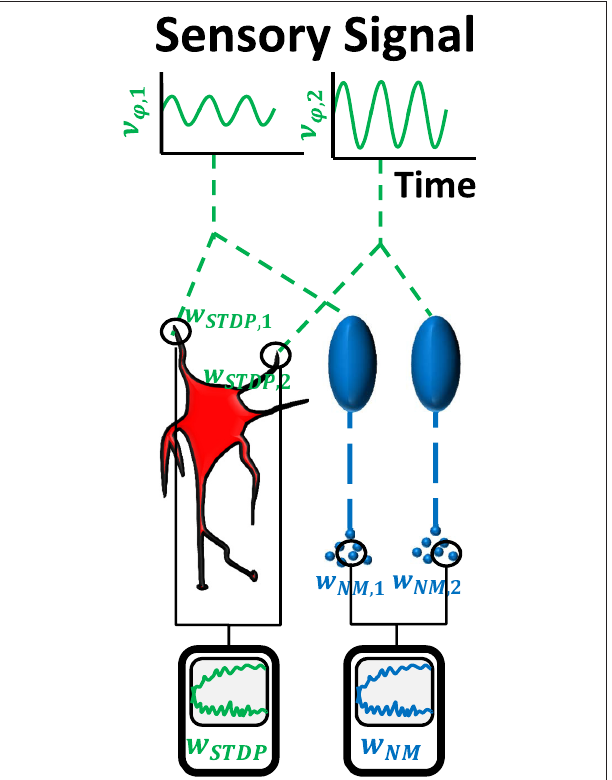
FIGURE 2 | In the first experiment, we verify the possibility to use STDP and serotonin dynamics to obtain the dominant principle component of input signals, by simulating two sensory Poisson neurons. Shown here are their firing rates that evolve according to sinus functions ν ϕ, 1 and ν ϕ, 2 with different amplitude and underlying white noise (noise not illustrated in the picture). The neurons drive a third Poisson neuron (center left). Synaptic weights w STDP , i are subject to STDP and their ratio is expected to converge toward the amplitude ratio of the input sinus functions. Additionally, the input neurons drive two raphe neurons (center right), which release serotonin into separate pools. The serotonin concentration decreases according to Michaelis-Menten dynamics. The ratio of serotonin concentrations is proportional to the ratio of the neuromodulatory weights, w NM , 1 / w NM , 2 , and is also expected to converge toward the amplitude ratio of the input